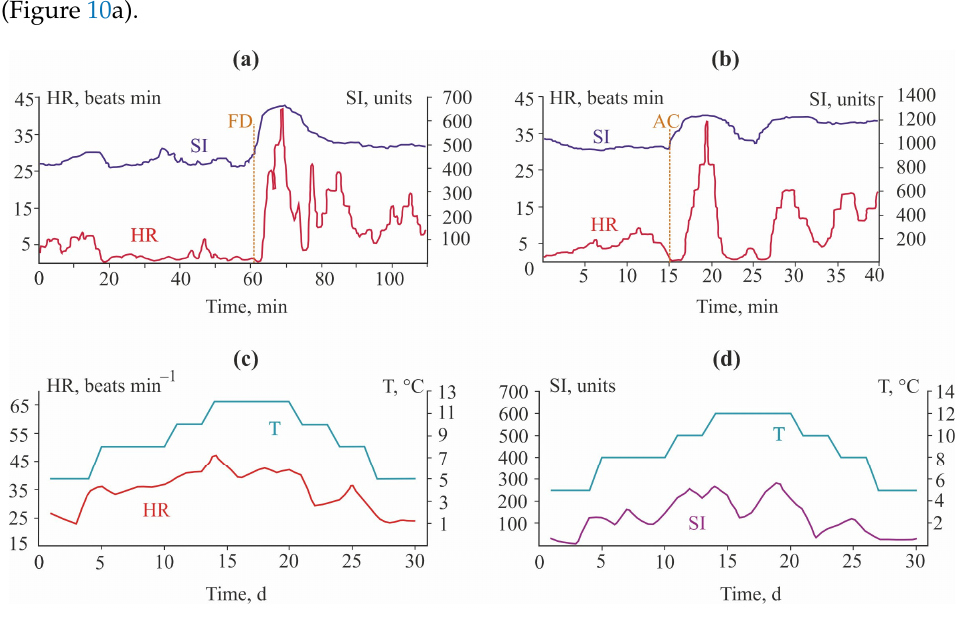
Figure 10. Heart rate (HR) and stress index (SI) of red king crab Paralithodes camtschaticus from the Barents Sea (modified from [102]: ( a ) during food consumption (FD—food added), ( b ) during mechanical stress (AC—aquarium cleaning), and ( c , d ) during temperature fluctuations.